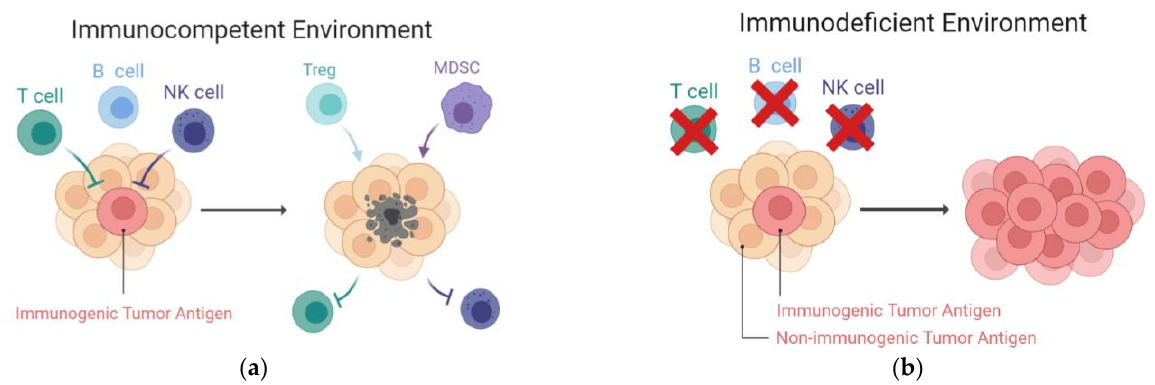
Figure 3. Increased immunogenicity of tumors developed in immunodeficient hosts. ( a ) In immunocompetent hosts, tumors with high immunogenicity will be spontaneously destroyed by the T cells and NK cells. The resulting tumors, which express low immunogenicity, survive and create a suppressive TME. Within the TME, inhibitory cells, such as Tregs and MDSCs, facilitate tumor progression and deplete the effector cells; ( b ) In contrast, tumors established in an immunocompromised host are more malignant and immunogenic. Without the selective pressures from T and NK cells, antigenic tumors are retained. MDSCs, myeloid-derived suppressive cells; NK cells, natural killer cells; TME, tumor microenvironment; Tregs, regulatory T cells.